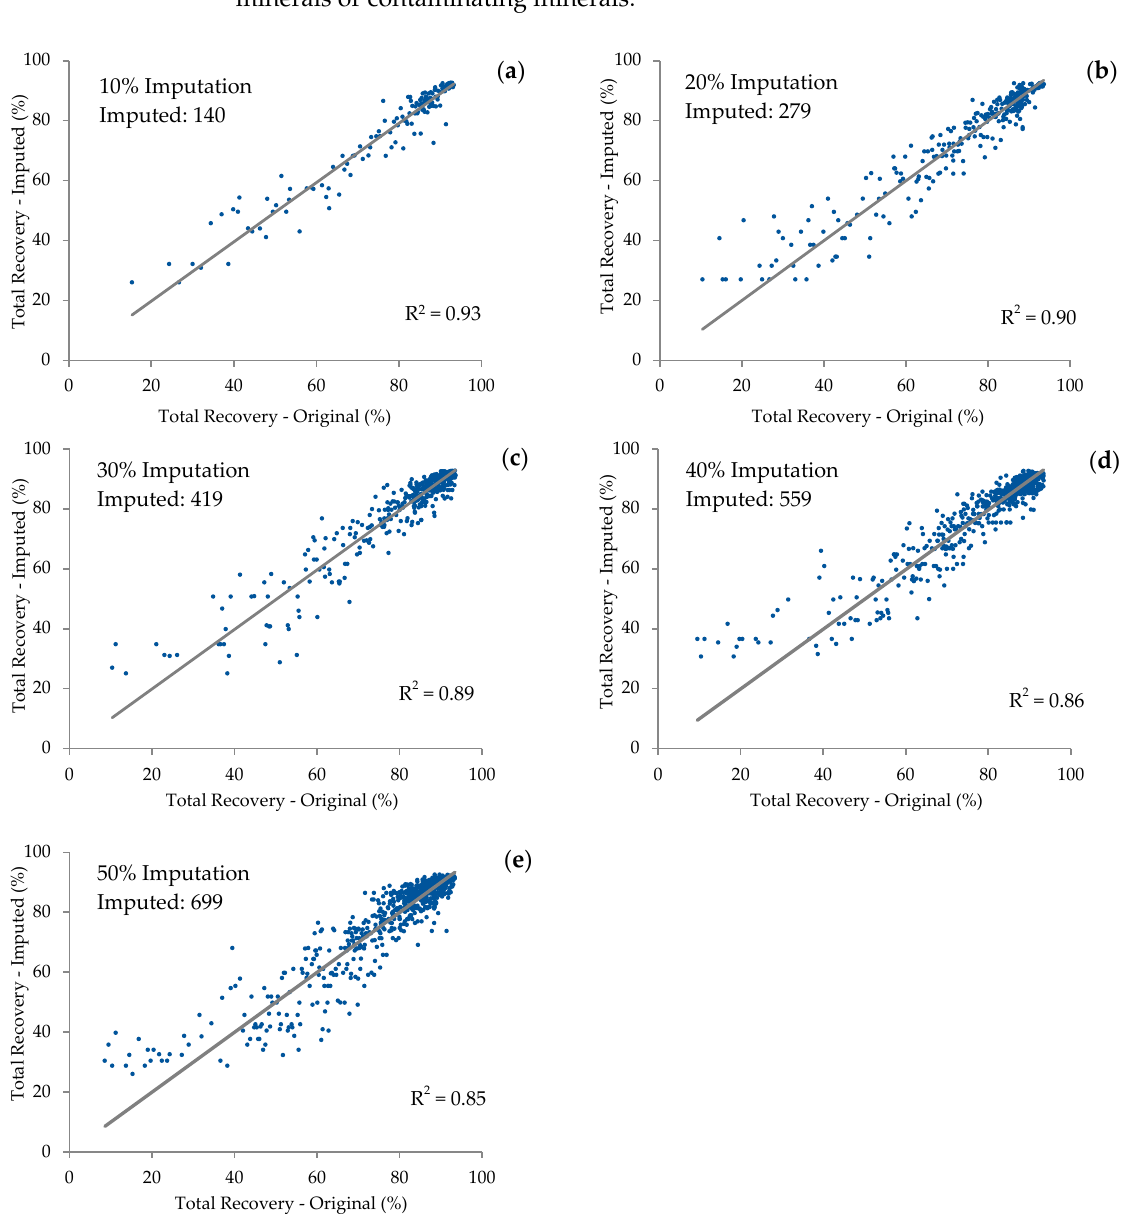
Figure 13. Coefficient of determination data from 10 to 50% samples exclusion.